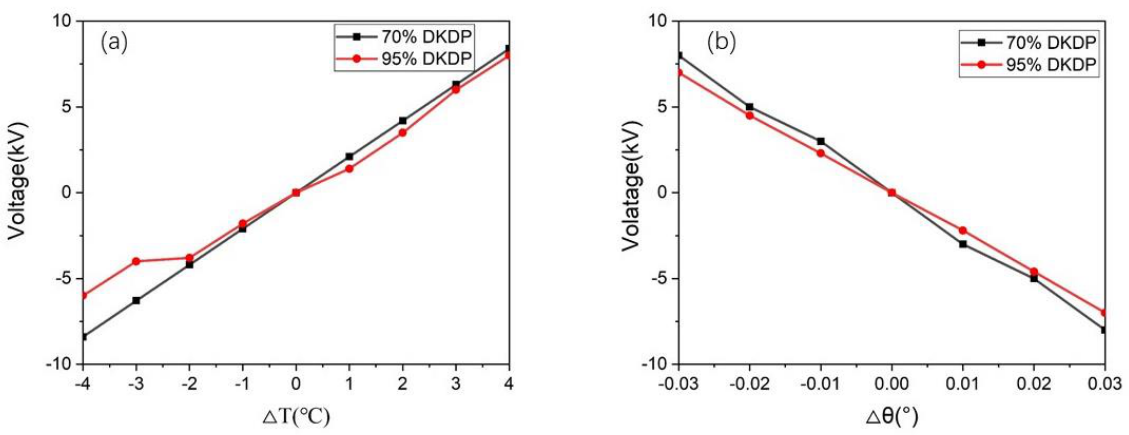
Figure 7. ( a ) Experimental phase mismatch compensation voltage versus temperature; ( b ) experimental phase mismatch compensation voltage versus angle.